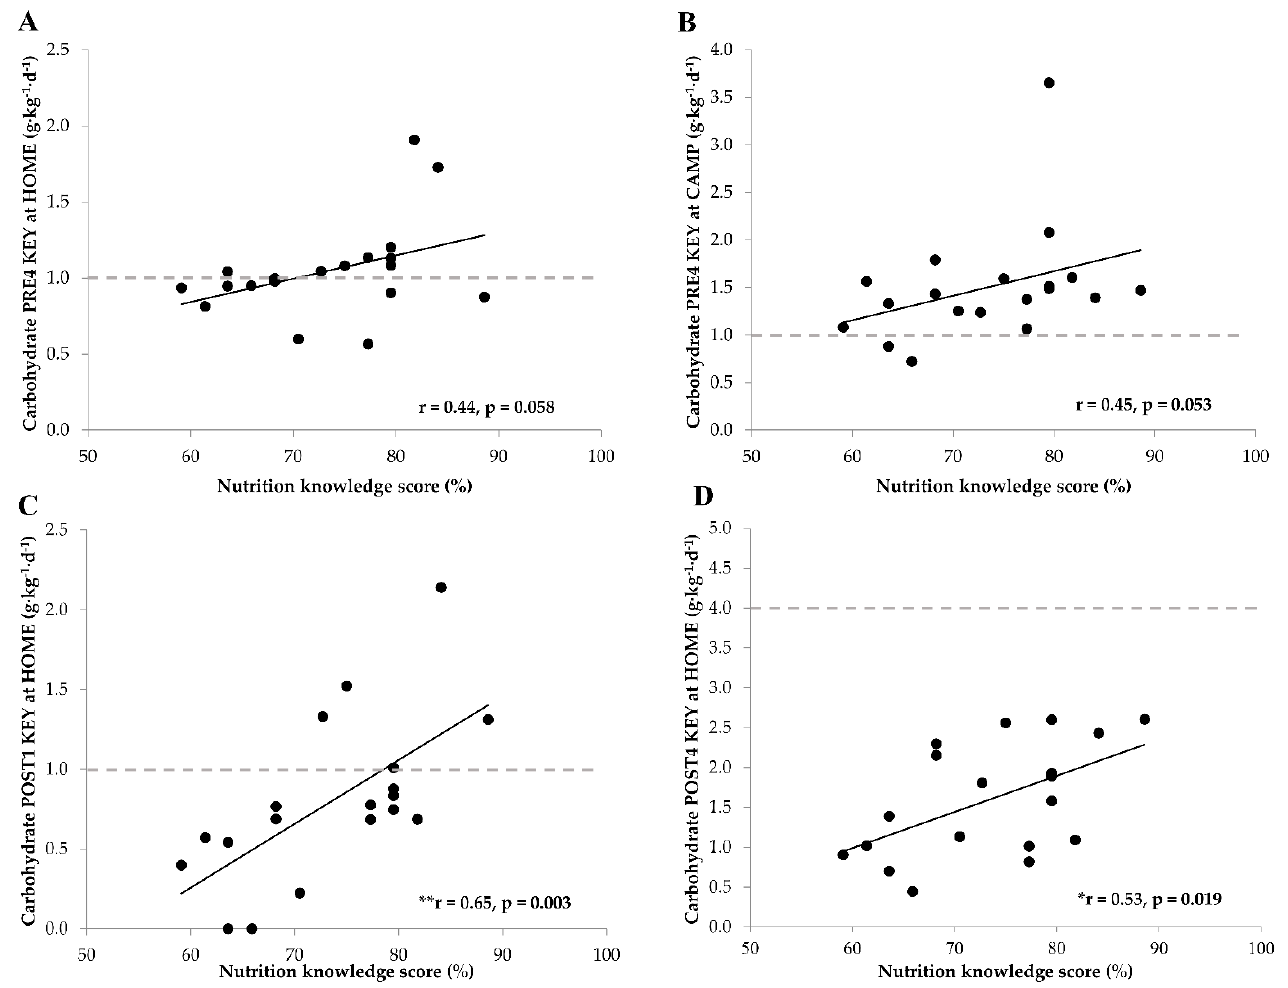
Figure 2. Associations between nutrition knowledge score and carbohydrate intake before (A, B) and after (C, D) KEY training sessions. The gray horizontal dotted line denotes the consensus statement recommendations for optimal carbohydrate intake [13]. PRE4 = within four hours before exercise; POST1 = within an hour after exercise; POST4 = within four hours after exercise; HOME = during home training; CAMP = during training camp; KEY = key training session; * p < 0.05; ** p < 0.01 significant correlation.